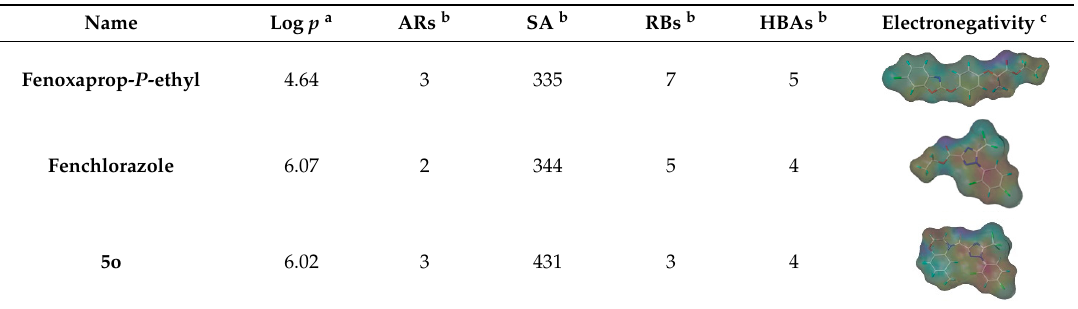
11 of 15 Figure 2. Sequence of activity with different substitution.